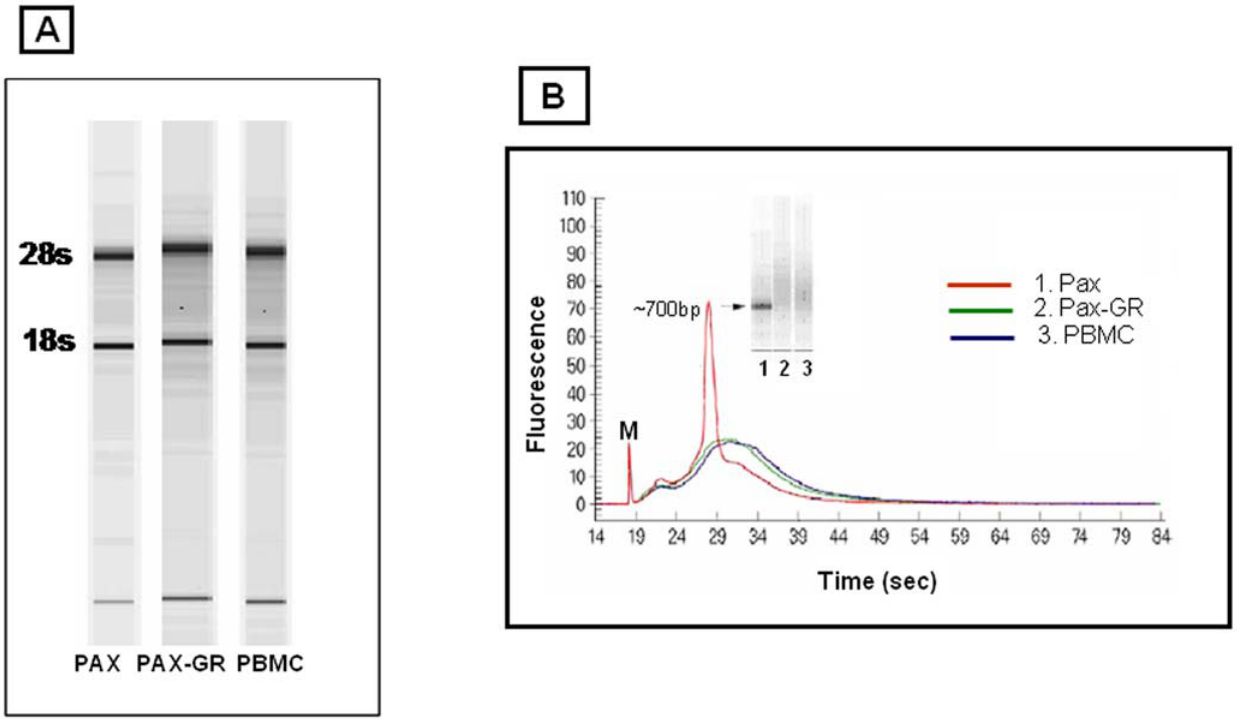
Figure 1. A. Quality of total RNA from PBMC, PAX and PAX-GR. The intact 18 and 28s ribosomal bands are shown in the electophoregram determined in agilent bioanalyzer. B. Quality of biotinylated cRNA from PBMC, PAX and PAX-GR. A predominant 700 bp peak represents the globin cRNA in the PAX samples. cRNA from PBMC and PAX-GR show a similar pattern of a smear of transcripts. 1 . Red line - PAX . 2 . Blue line - PAX- GR . 3 . Green line - PBMC .